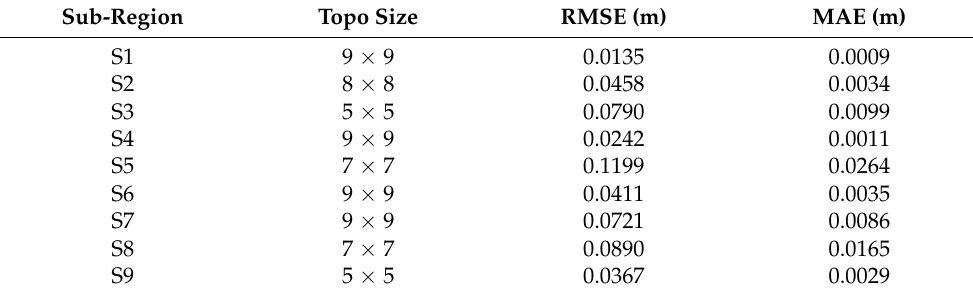
Table 5. The optimal parameters of